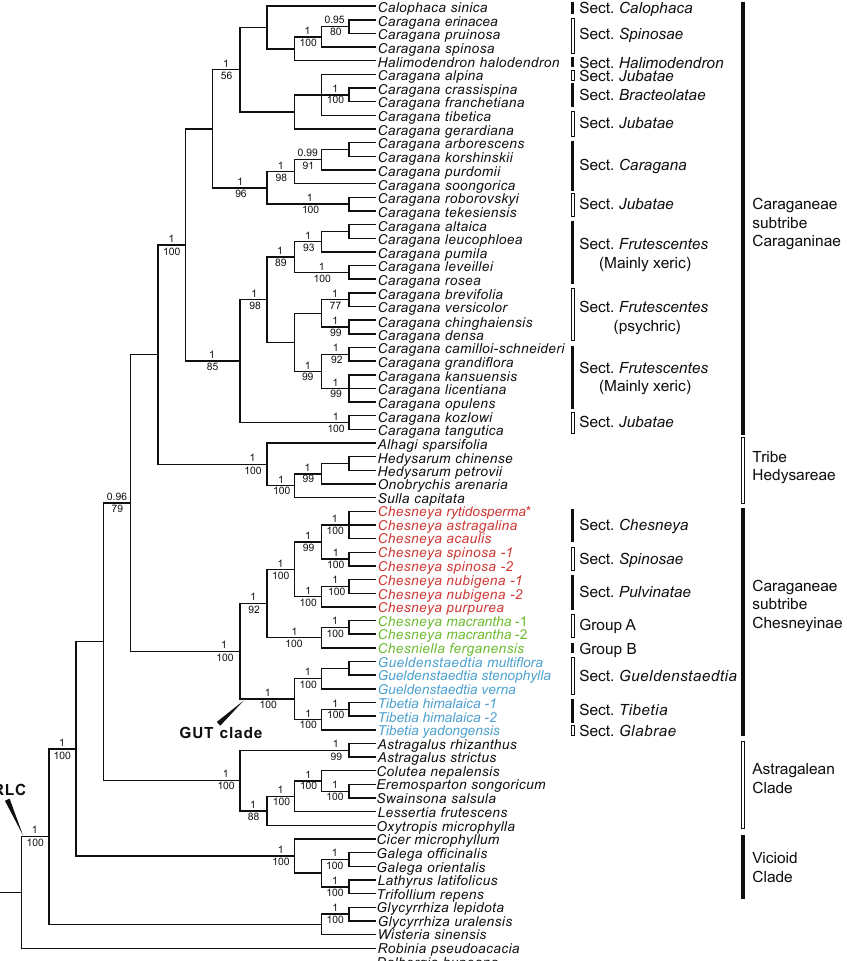
Figure 2. Bayesian tree of the concatenated plastid data of matK , trnL-F and psbA-trnH sequences, showing genera in subtribes Caraganinae, Chesneyinae and their close relatives. The labeled sections of Gueldenstaedtia and Tibetia followed Tsui (1979) and Zhu (2005a), respectively. Bayesian posterior probabilities (PP ≥ 0.95) and maximum likelihood bootstrap (LBS ≥ 70%) are given above and below branches, respectively. The asterisk indicates the type species of Chesneya . with C. sect. Bracteolatae (Kom.) M.L.Zhang (PP = 1, LBS = 100%), C. sect. Caragana Kom. (PP = 1, LBS = 98%), C. sect. Frutescentes (Kom.) Sanchir (PP = 1, LBS = 98%) and C. sect. Spinosae (Kom.) Y.Z.Zhao (PP = 1, LBS = 100%) each strongly supported. Unlike in the ITS tree, Chesneya s.s. and Chesniella were sisters in the plastid tree (PP = 1, LBS = 92%; Fig. 2). As in the ITS tree, the GUT clade (PP = 1, LBS = 100%) con- tained Gueldenstaedtia (PP = 1, LBS = 100%) and Tibetia (PP = 1, LBS = 100%), with each genus being